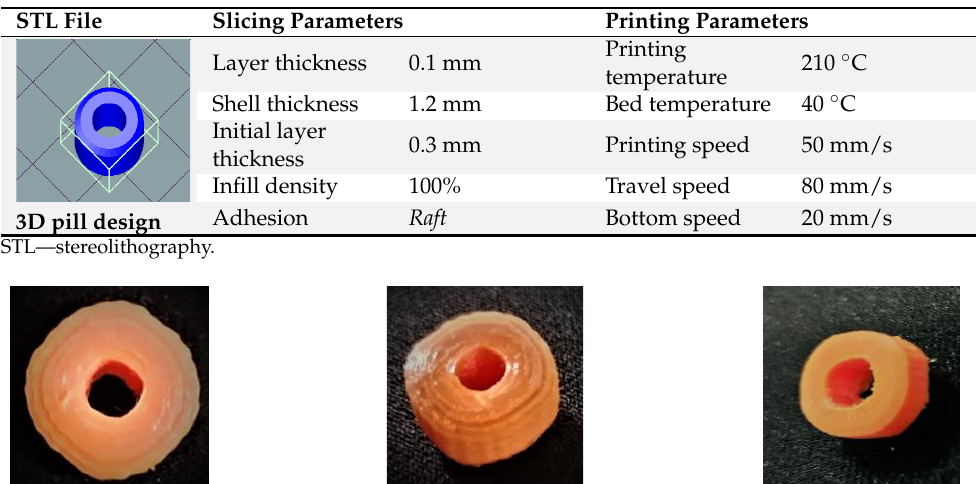
Figure 5. 3D pills fabricated by FDM using PLA encapsulated with BAB. 3.5. Fourier Transform Spectroscopy BAB in the pure drug spectrum exhibits the characteristics peaks at 3345 cm −1 , 3012 cm −1 , 2654 cm −1 , and 2322 cm −1 for the N-H stretching, aromatic = C–H stretching, –C–H stretching, and –C=N stretching. Moreover, characteristics peaks were observed at 1579.7 cm −1 , 1442.96 cm −1 , 1251.09 cm −1 , 1322.80 cm −1 , 1291.65 cm −1 , 1261.41 cm −1 , 1135.08 cm −1 , 926.77 cm −1 , 673.06 cm −1 , and 601.07 cm −1 , identical to the results in the BAB drug (Figure 6a). However, PLA showed prominent functional group peaks at 3100.15, 1741.79, 1366.09, 1212.42, and 1084.87 cm −1 for -OH (COOH), –CH3(S), –C=O, –C–O (COOH)–OH, –CH3(B) functional groups, respectively (Figure 6b). The characteristic peaks of drug and polymer (PLA) were identical in the 3DP1 and 3DP2 filaments, suggesting that BAB was success- fully encapsulated within the PLA filament used for pill fabrications (Figure 6c,d). More- over, the FTIR spectrums of 3D pills fused with BAB shown in (Figure 6e,f) also exhibit the identical peaks of drug and polymer accords compatibility of PLA with BAB. De- creased intensities of the peaks could be due to the heating temperature used in the fabri- cation of pills by which the molecules will occupy the excited vibrational states.